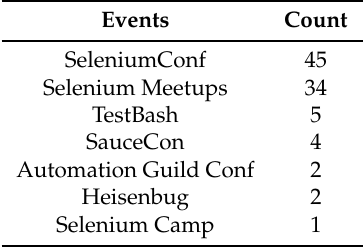
Table A20. 6.c. What, in your opinion, are the most relevant events related to Selenium?